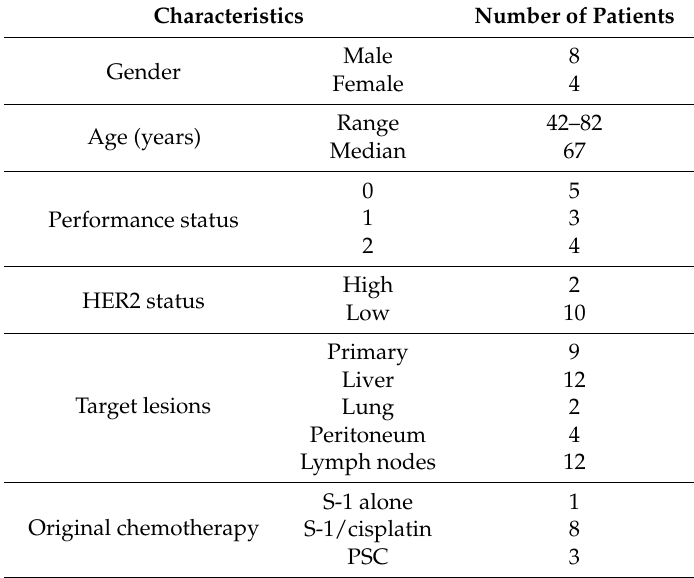
Table 1. Characteristics of gastric cancer patients with liver metastases receiving